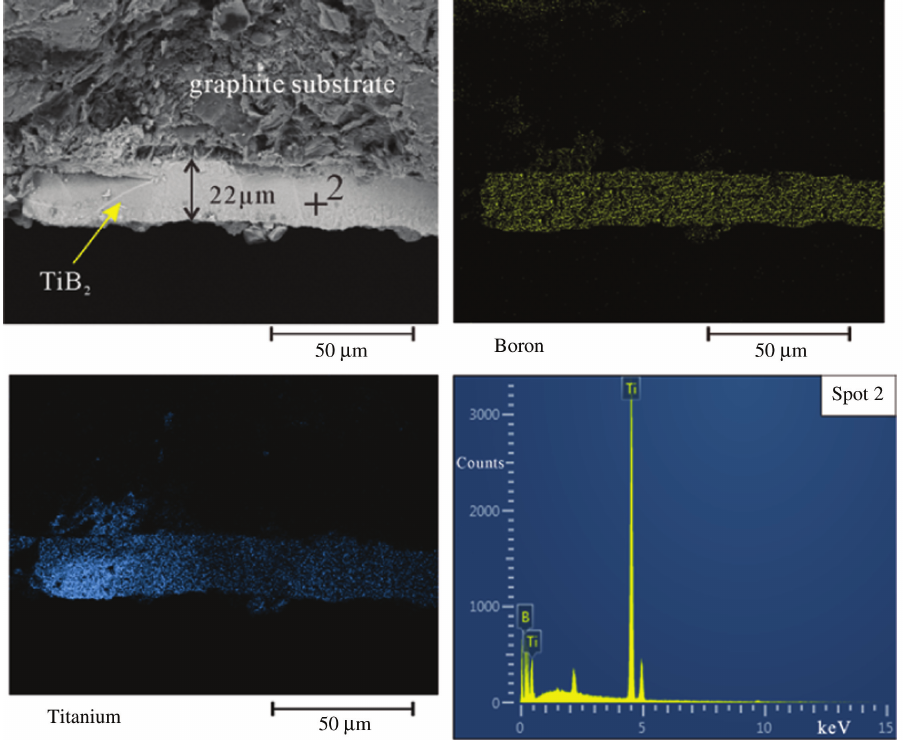
Table 2: The EDS analysis results of different regions of samples in Figures 4 and 5.